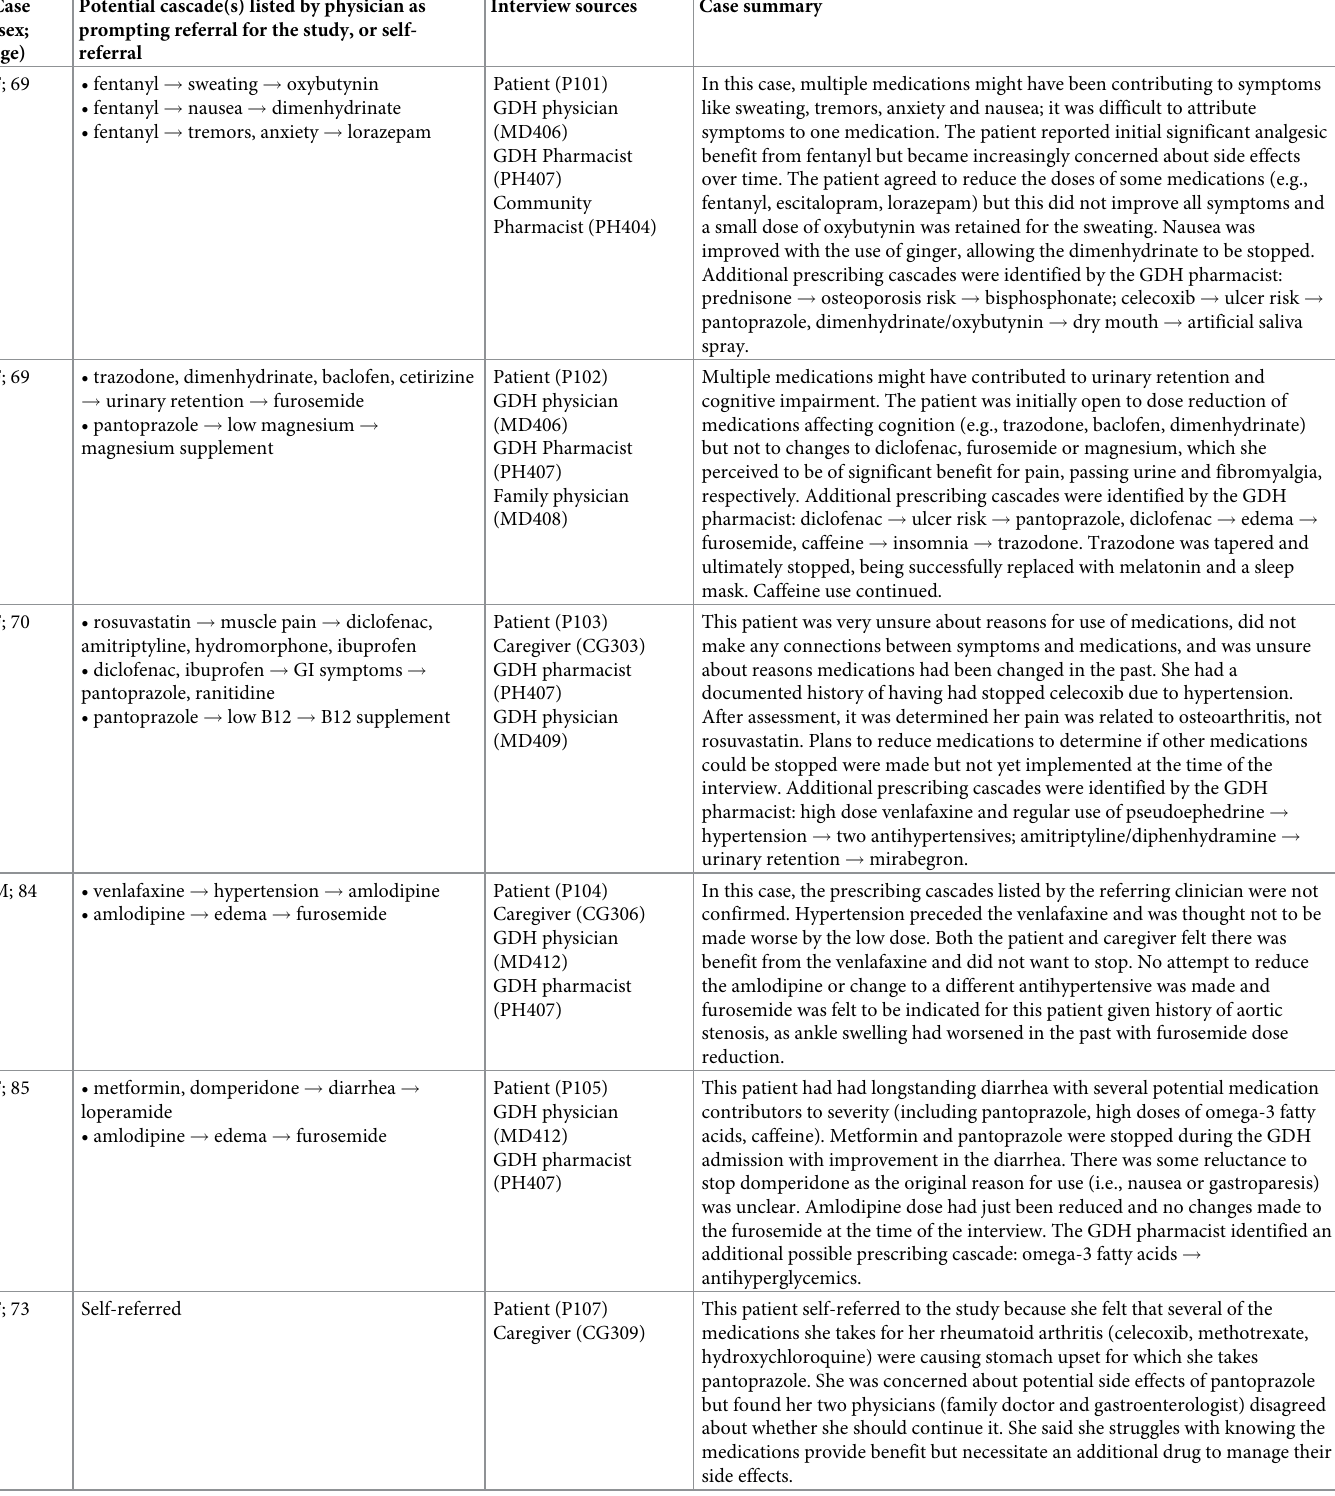
Table 1. Case summaries of prescribing cascade